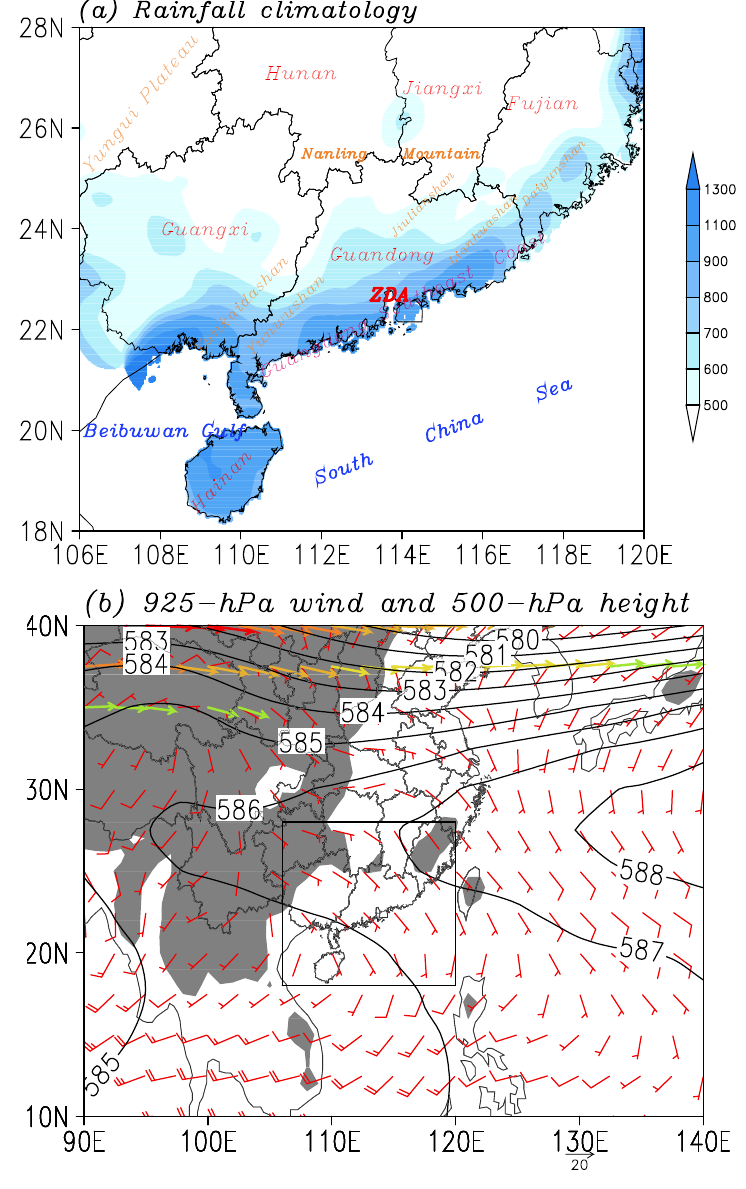
Figure 1. ( a ) Mean rainfall (shaded, unit: mm) from July to September for the period of 2000–2009 (based on observations of weather stations in China) and ( b ) mean 925-hPa wind (barbs, unit: m·s –1 ; a full barb represents 5 m·s –1 ), 500-hPa geopotential height (contours, unit: dagpm (decade geopotential meter)) and 200-hPa westerly wind greater than 20 m·s –1 (vectors, unit: m·s –1 ) from the National Center for Environmental Prediction (NCEP) reanalysis at 2.5° resolution. ZDA in (a) indicates the Zhujiang Delta Area (ZDA). The rectangle in (b) indicates the area of Figure 1a. The shading area in Figure 1b indicates topography higher than 1,500